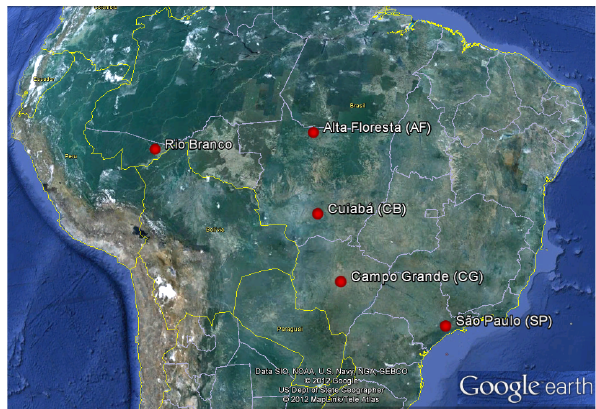
Fig. 1. Map of Brazil showing the five sites used in this validation study. The Rio Branco site (RB) is located in the northern region of Brazil, and Alta Floresta (AF), Cuiabá (CB) and Campo Grande (CG) are located in the midwestern region. The primary vegetation in all four of these regions is either savannah or rainforest, and can thus be considered as sources of biomass burning aerosol. São Paulo (SP) is located in the southeastern region of Brazil, which is heav- ily industrialized and whose atmosphere can contain many different types of